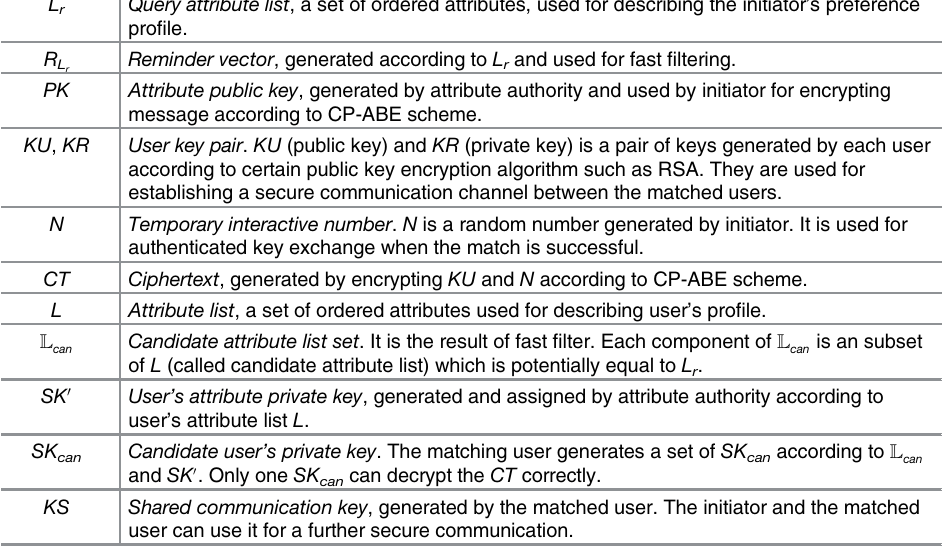
Table 2. Table of notations. L r Query attribute list , a set of ordered attributes, used for describing the initiator ’ s preference pro fi le. Reminder vector , generated according to L r and used for fast fi R L r